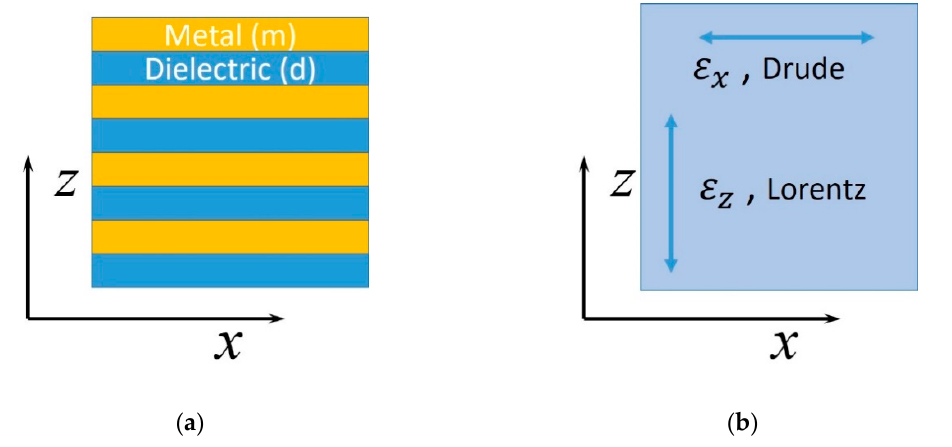
Figure 1. The effective medium consisting of a periodically arranged dielectric and metal layers. ( a ) The original layer structure. Here, the thickness of each layer as well as the lattice constant (the thickness of the unit cell) are assumed to be much smaller than the operating wavelength, so the effective medium theory can be constructed. ( b ) The effective medium has different dynamical properties in the direction parallel and perpendicular to the layers.